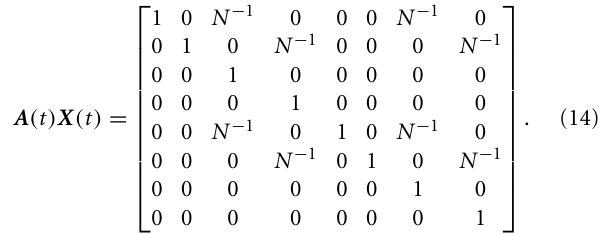
I 4 N × 4 N is a diagonal matrix with dimension 4 N × 4 N . The matrix